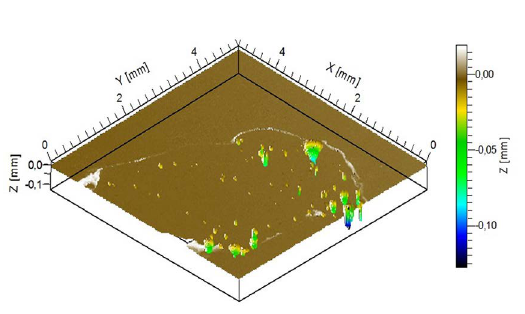
Figure 16. Topography of the 316L steel showing the depth and the distribution of the pits after pressurized tests.